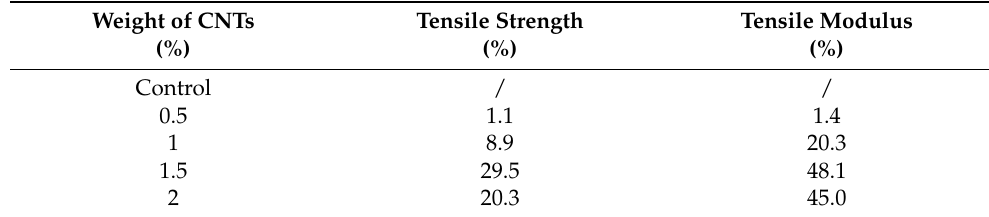
Figure 7. Dependence of tensile properties of epoxy/CNT nanocomposites on the weight concentration of CNTs of ( a ) tensile strength and ( b ) tensile modulus. Table 2. Increased percentage of tensile strength and modulus with the weight concentration of